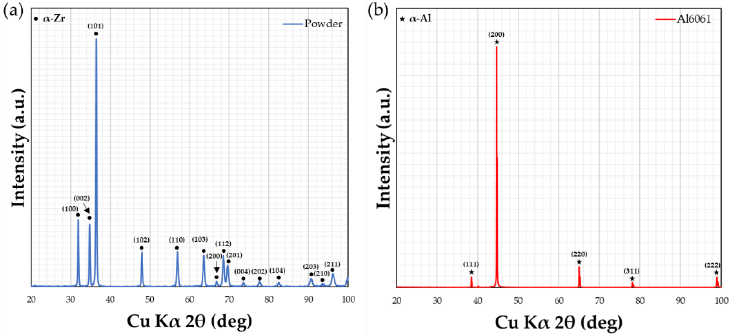
Figure 1. XRD patterns of the ( a ) Zr powder and ( b ) Al6061 used in this work as substrate. Table 1. Processing parameters of CS deposition.